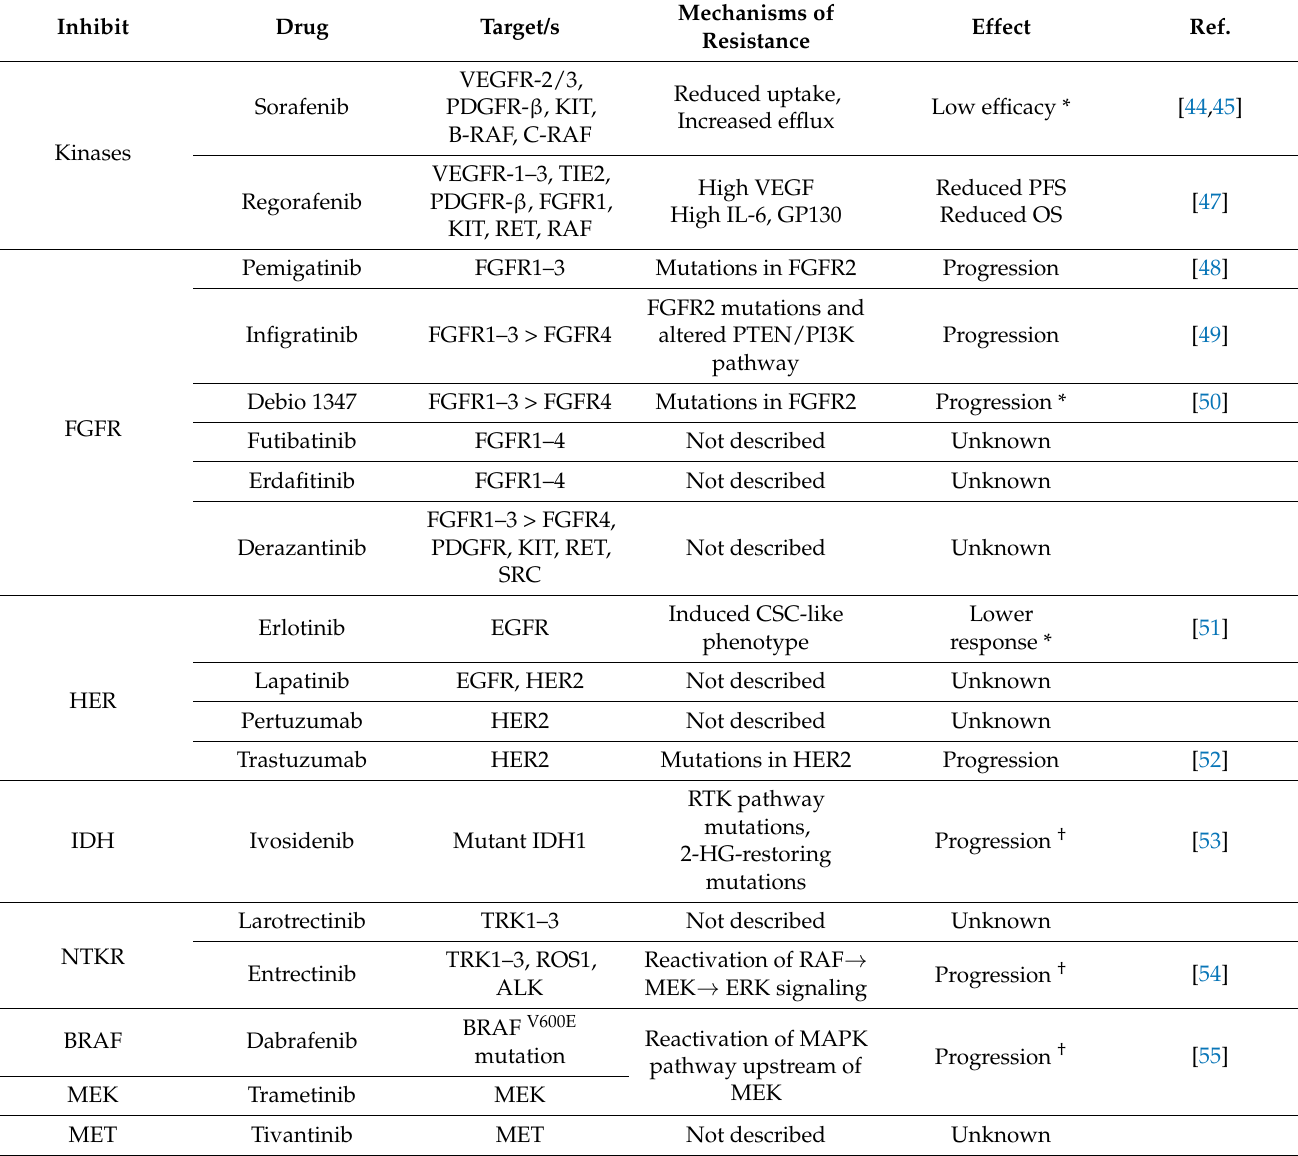
Table 2. MPRs to targeted therapy in